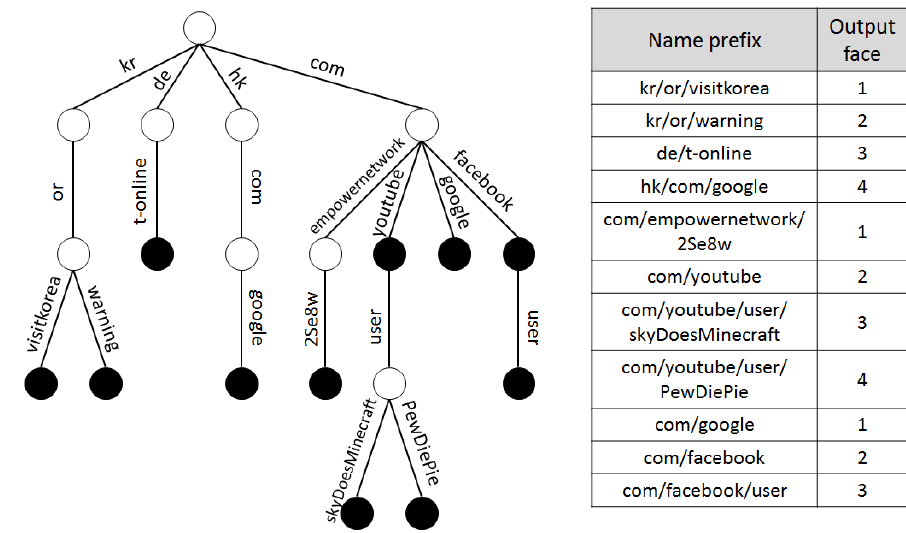
Figure 1. Name prefix